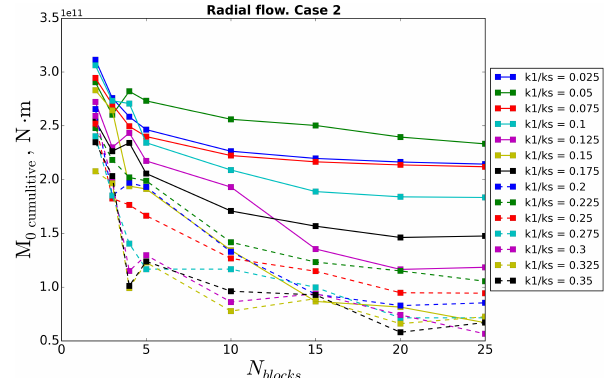
Figure 14. Cumulative seismic moment vs. number of